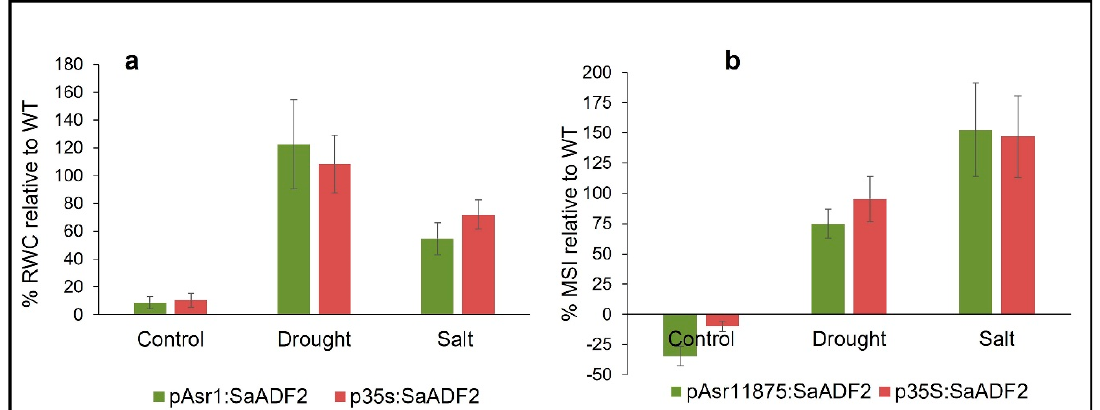
Figure 5. Physiological response expressed as percentage increase in relative water content (RWC; ( a )) and membrane stability index (MSI; ( b )) of Arabidopsis mutants overexpressing SaADF2 gene under pAsr1 1875 and constitutive p35S promoter relative to wild-type (WT) after 1 week of exposure to drought stress and salt (150 mM NaCl) stress.